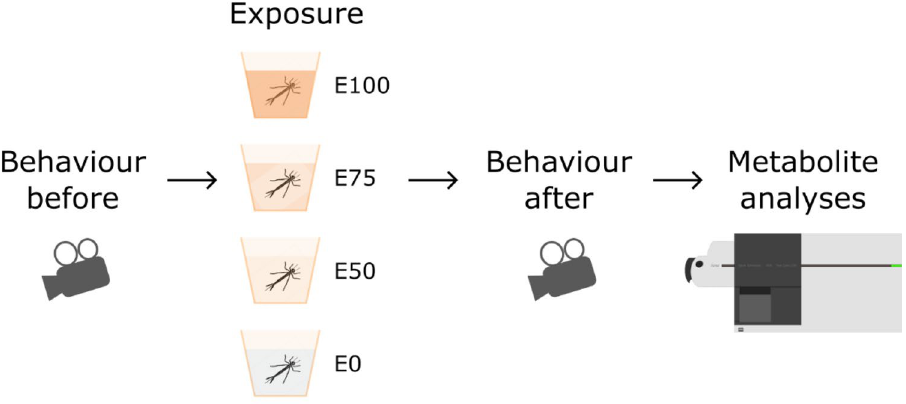
Figure 1. Study design showing the relative ordering of two sets of behavioural trials, the wastewater effluent exposure (7 days), and then metabolite